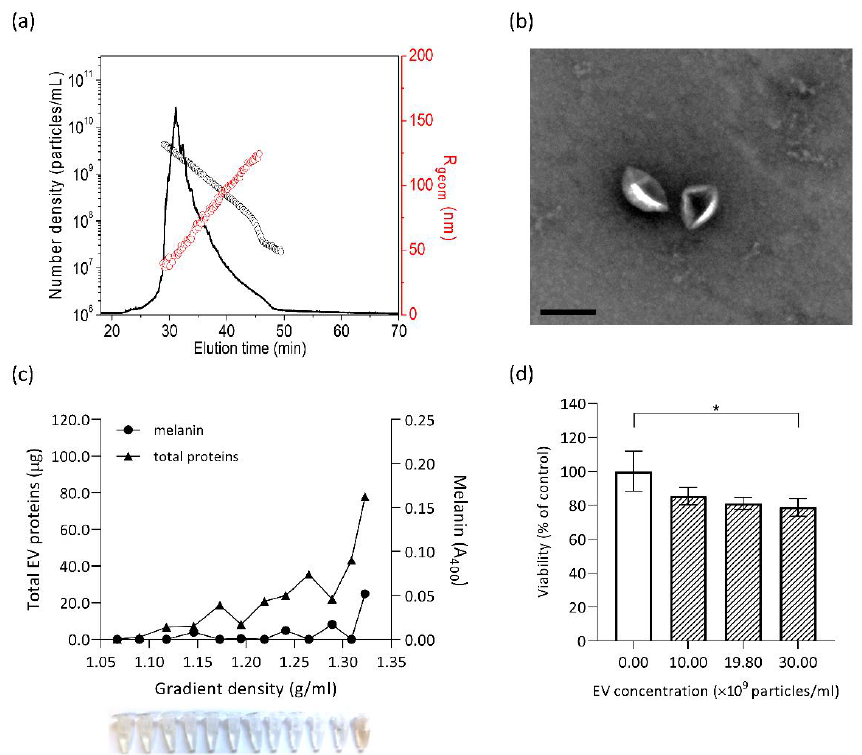
Figure 5. Melanin component of the Exophiala dermatitidis EVs is responsible for the SH-SY5Y cytotoxic effect. Morphological and molecular characterisation of E. dermatitidis EVs isolated from culture with added tricyclazole. ( a ) Normalized AF4-MALS fractogram (black line) of non-melanised EVs for R geom (red circles) and number density (black circles). ( b ) TEM micrograph of non-melanised E. dermatitidis EVs; scale bar: 250 nm. ( c ) Velocity gradient centrifuged fractions of non-melanised E. dermatitidis EVs were collected and analysed for density, total EV proteins (µg), and melanin content (A 400 ). ( d ) The cytotoxic effect of non-melanised E. dermatitidis EVs, added at the indicated final concentrations, on SH-SY5Y cells, as measured by the neutral red uptake viability assay. Data are presented as the mean ± SD of triplicate samples inside one experiment where the first, uncoloured bar represents viability of control without added EVs (100%) (* p < 0.05; Kruskal–Wallis statistics). To compare the function of non-melanised EXF-10123 EVs with those containing melanin, we performed a neutral red uptake viability assay, as described above. After exposure to SH-SY5Y cells, such non-melanised EVs, even at the highest concentration of 3.0 × 10 10 EVs/mL, showed only minor cytotoxic effect on SH-SY5Y cells, with 79% viability compared with control (statistical significance p = 0.0347; Figure 5d). We conclude that the melanin component of EXF-10123 EVs is important for the cytotoxic effect on SH-SY5Y cells (see the comparison on survival diagram, Figure S4).